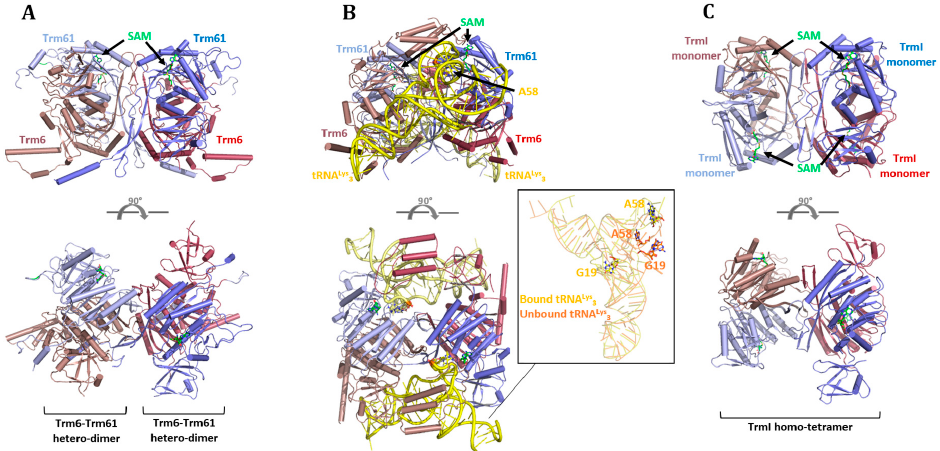
Figure 5. Structures of m 1 A58 tRNA MTases: ( A ) Trm6–Trm61 heterotetramer (PDB 5ERG); ( B